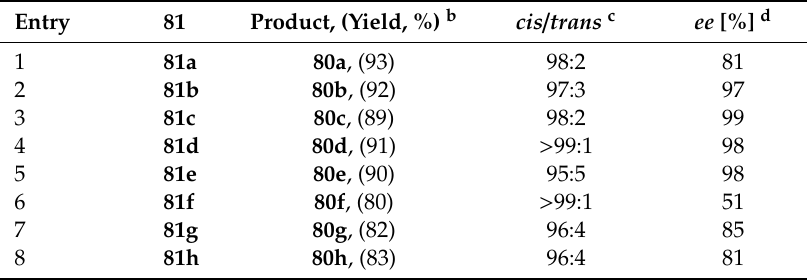
Table 3. Stereoselective synthesis of trans -(1 R ,2 R ,3 S )-trisubstituted cyclopropanes 80 . a